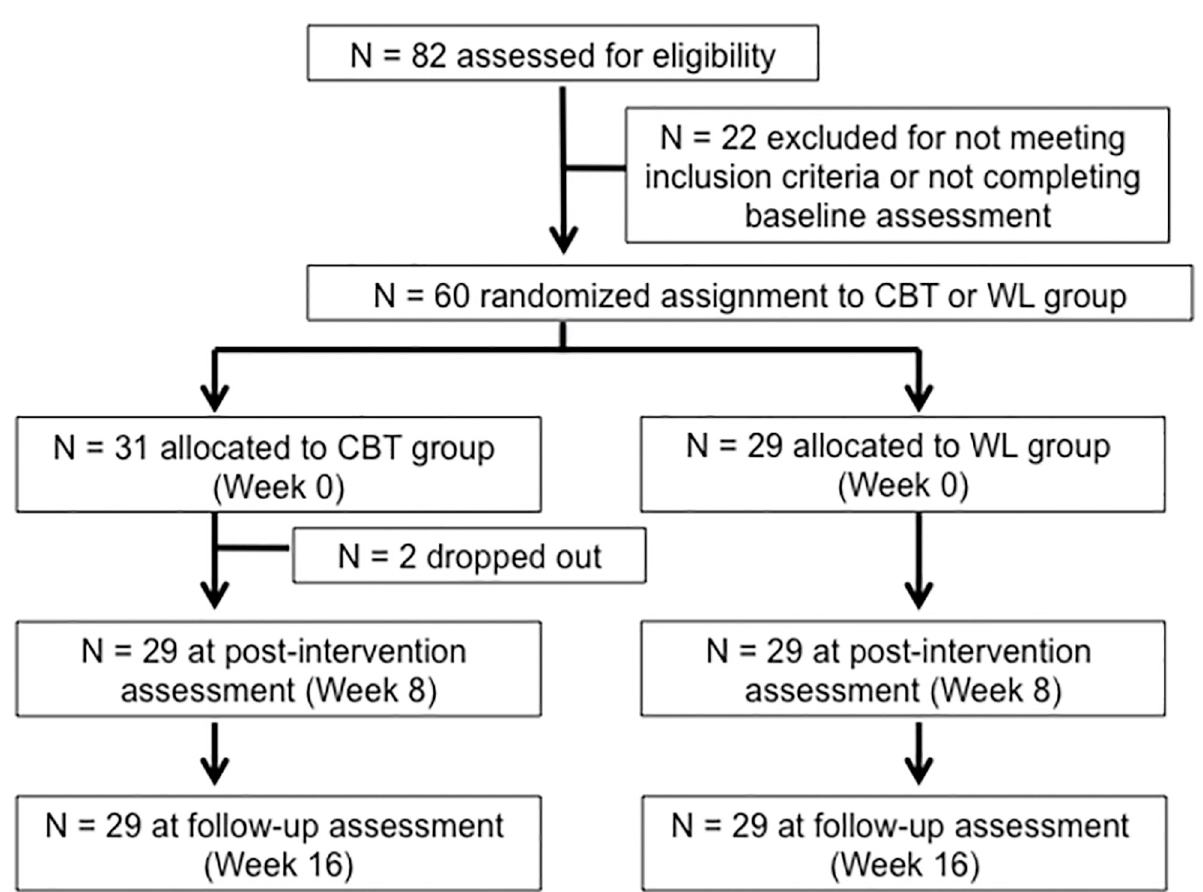
Fig 1. CONSORT flow diagram. Similar numbers of participants were allocated to the CBT and WL groups. Assessments were performed within four weeks prior to the start of the CBT/waiting period (pre-intervention), within four weeks after the conclusion of CBT/waiting period (post-intervention), and 12 weeks thereafter (follow-up). Abbreviations: CBT, cognitive-behavioral therapy; WL, waitlist.